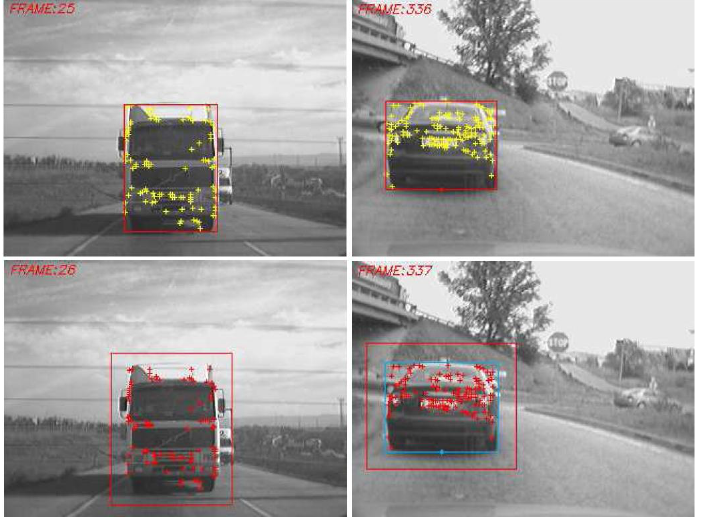
Figure 13. Data association by features matching. Upper row: Harris features on image t . Lower row: matched Harris features on image t +